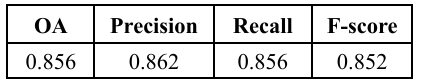
Table 5. Performance metrics obtained after selecting the